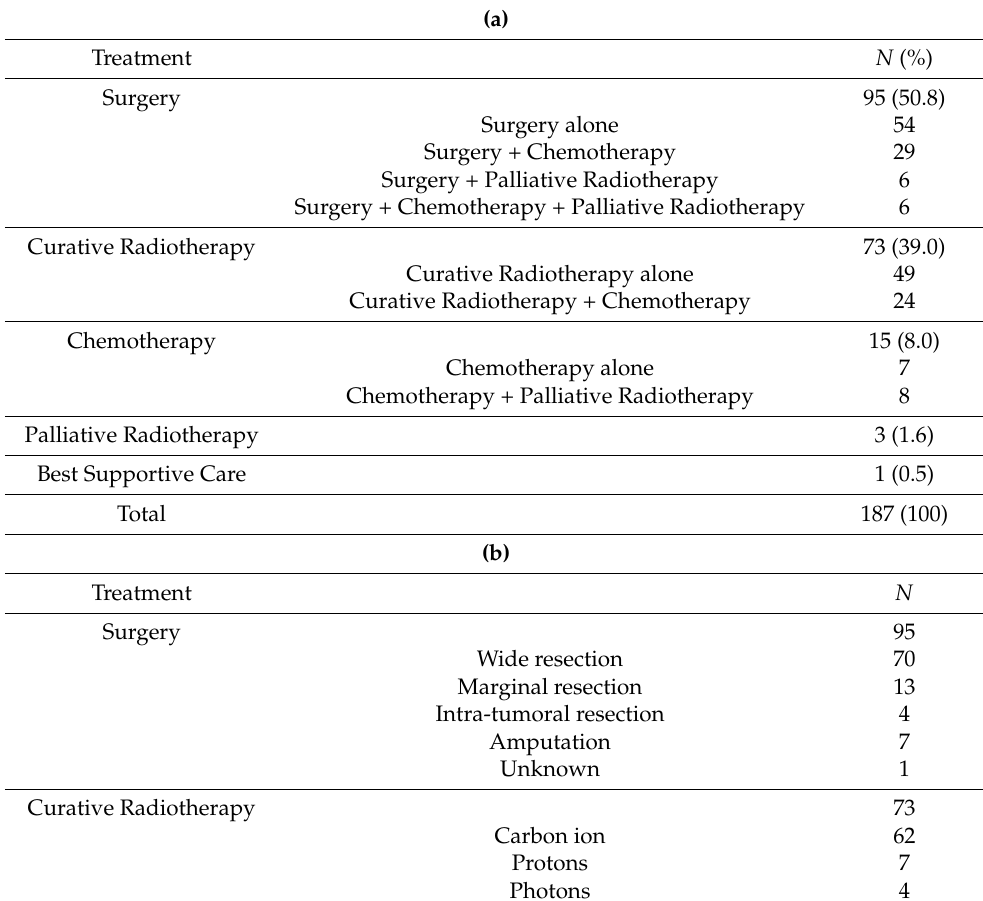
Table 3. ( a ) Treatments for primary tumor. ( b ) Treatment details of surgery and curative